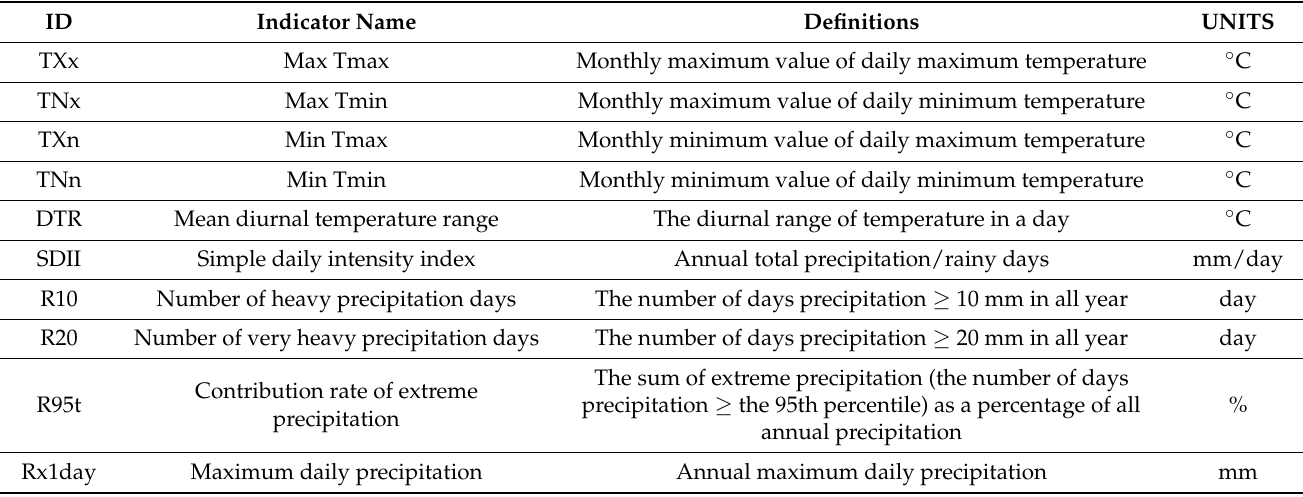
Table 1. Definitions of 10 extreme weather event